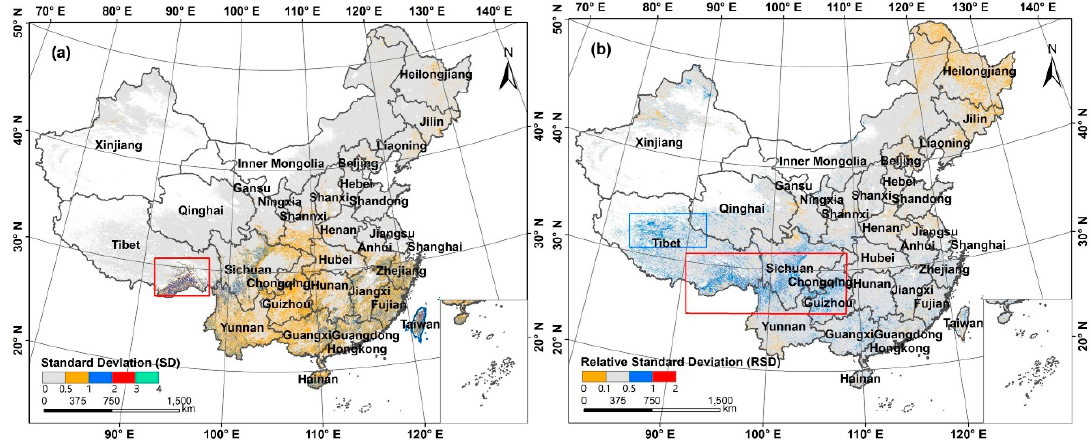
Figure 10. Standard deviation and relative standard deviation of the four products: ( a ) Standard deviation; ( b ) relative standard deviation.